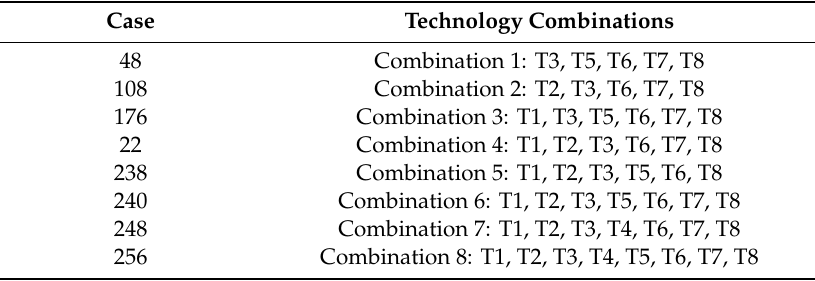
Table 13. Technology combinations satisfying root chord length